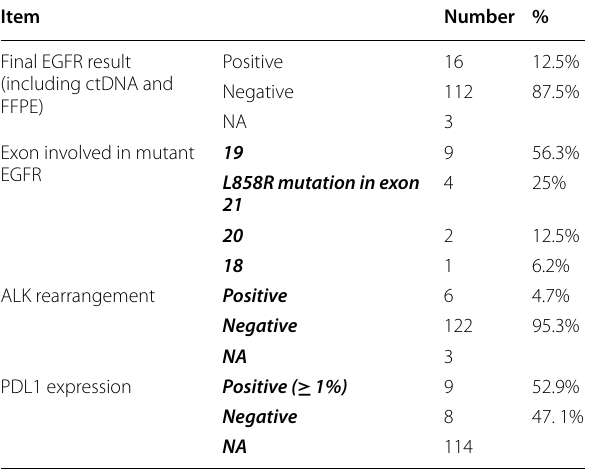
Table 2 Results of molecular testing in our cohort